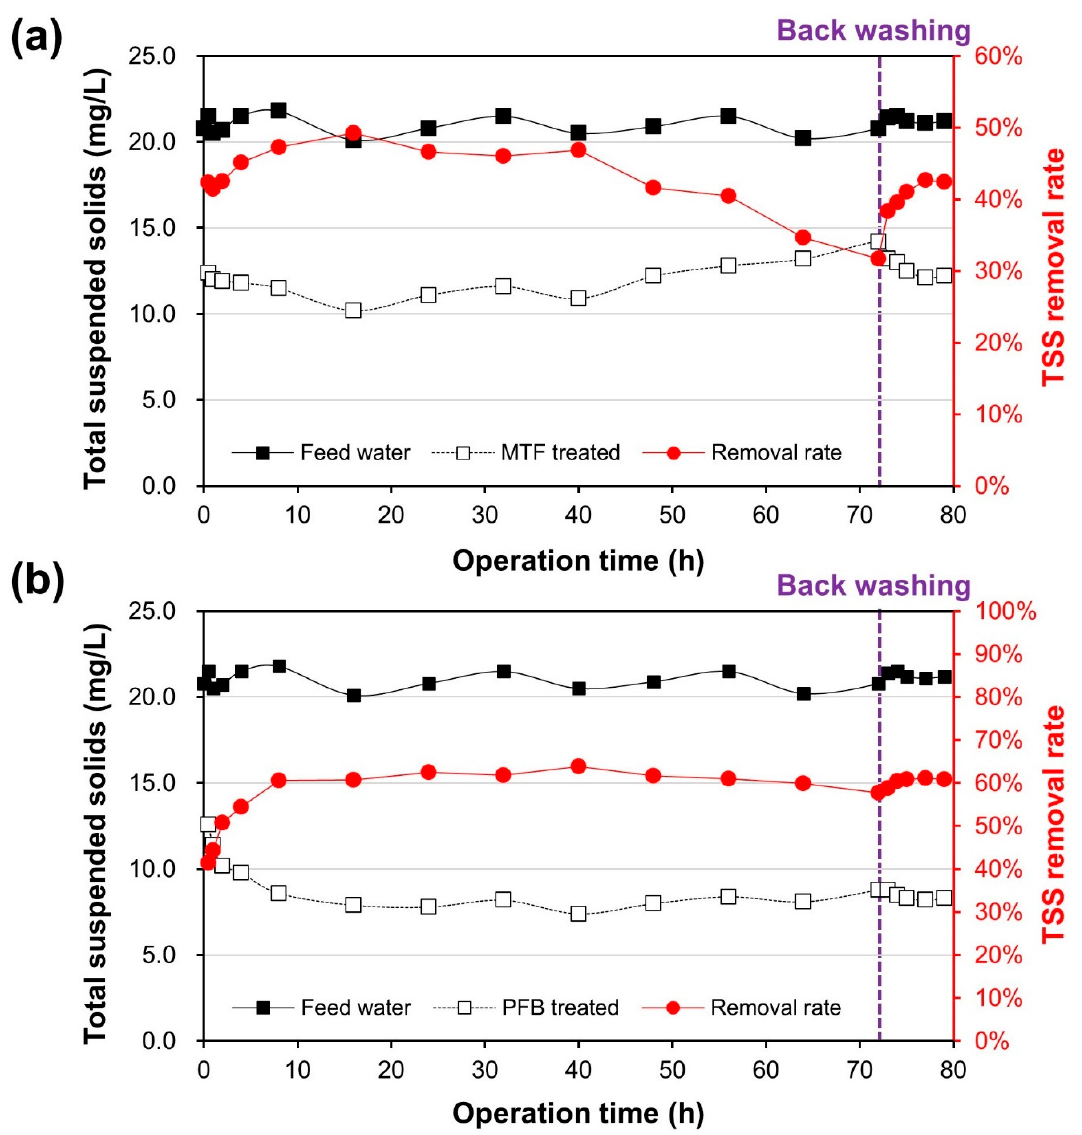
Figure 11. SP removal performance of MTF and PFB in a wastewater-seawater mixture: ( a ) TSS removal rate of MTF and ( b ) TSS removal rate of PFB.